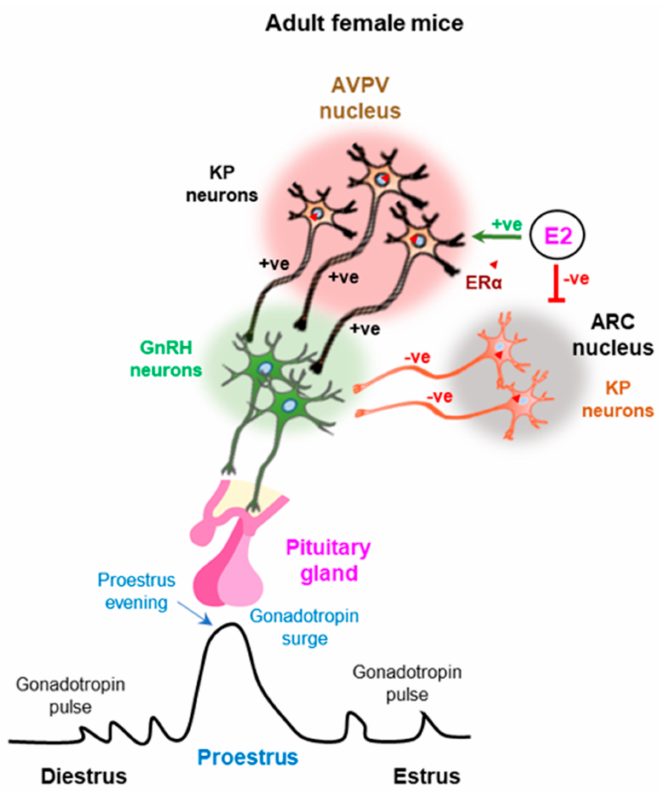
Figure 3. Estrogen feedback regulation of kisspeptin neurons in the arcuate and anteroventral periventricular nuclei. While estrogen negatively regulates the kisspeptin (KP) neurons in the arcuate (ARC) nuclei, positively regulates those in the anteroventral periventricular (AVPV) nuclei. ER α - mediated estrogen signaling in the KP neurons of ARC nuclei induces the pulsatile gonadotropin secretion during the estrus cycle. In addition, estrogen signaling in the KP neurons of AVPV nuclei induces preovulatory gonadotropin surge in proestrus evening. +ve, positive; − ve,